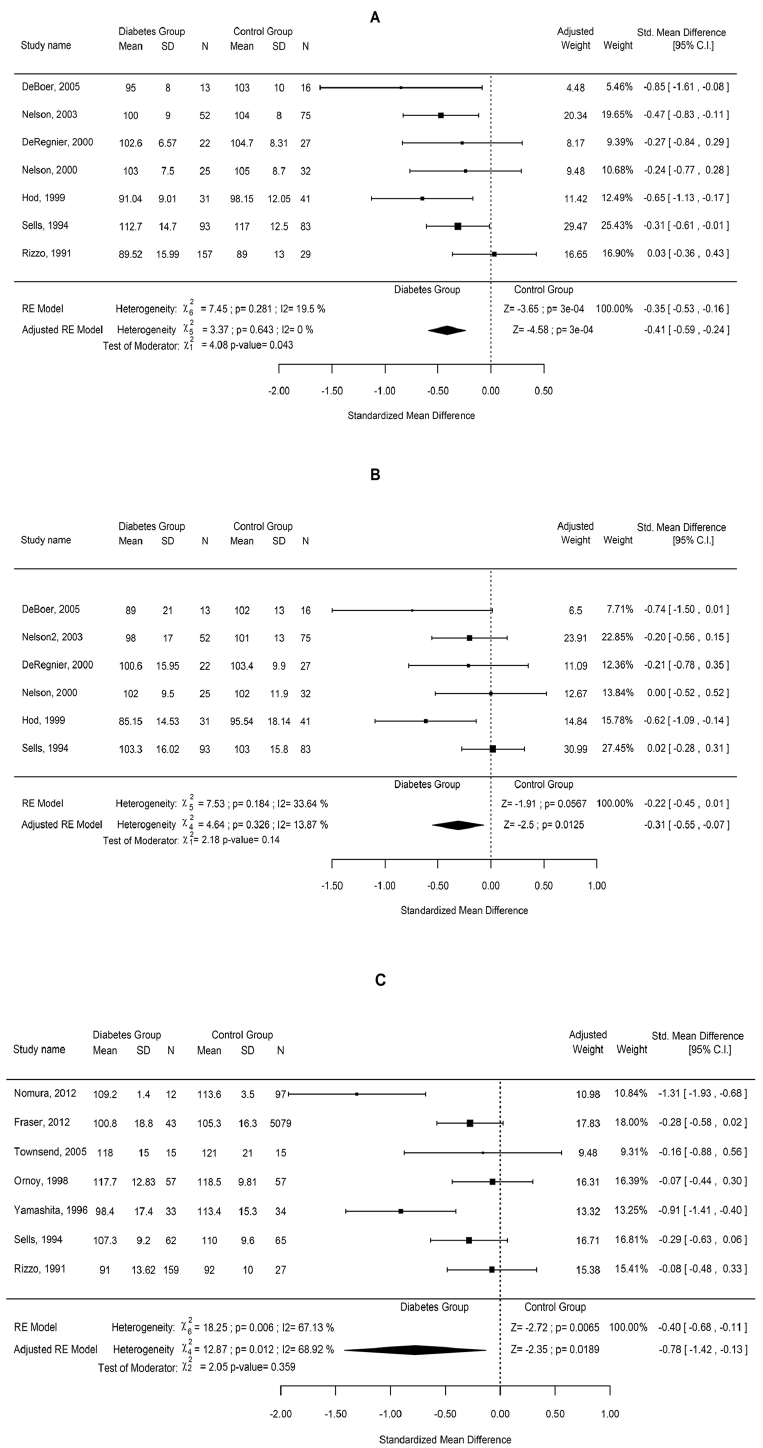
Fig 2. Effect of pregnancy diabetes on the mental and psychomotor development and intelligence quotient. Forest plots comparing the difference in the (A) Mental Development Index and (B) Psychomotor Development Index subscales of the BSID between children of diabetic and non-diabetic mothers. (C) Forest plots comparing the difference in the intelligence quotient yielded by combined data from the Wechsler scales and the Stanford-Binet intelligence scale between children of diabetic and non-diabetic mothers.